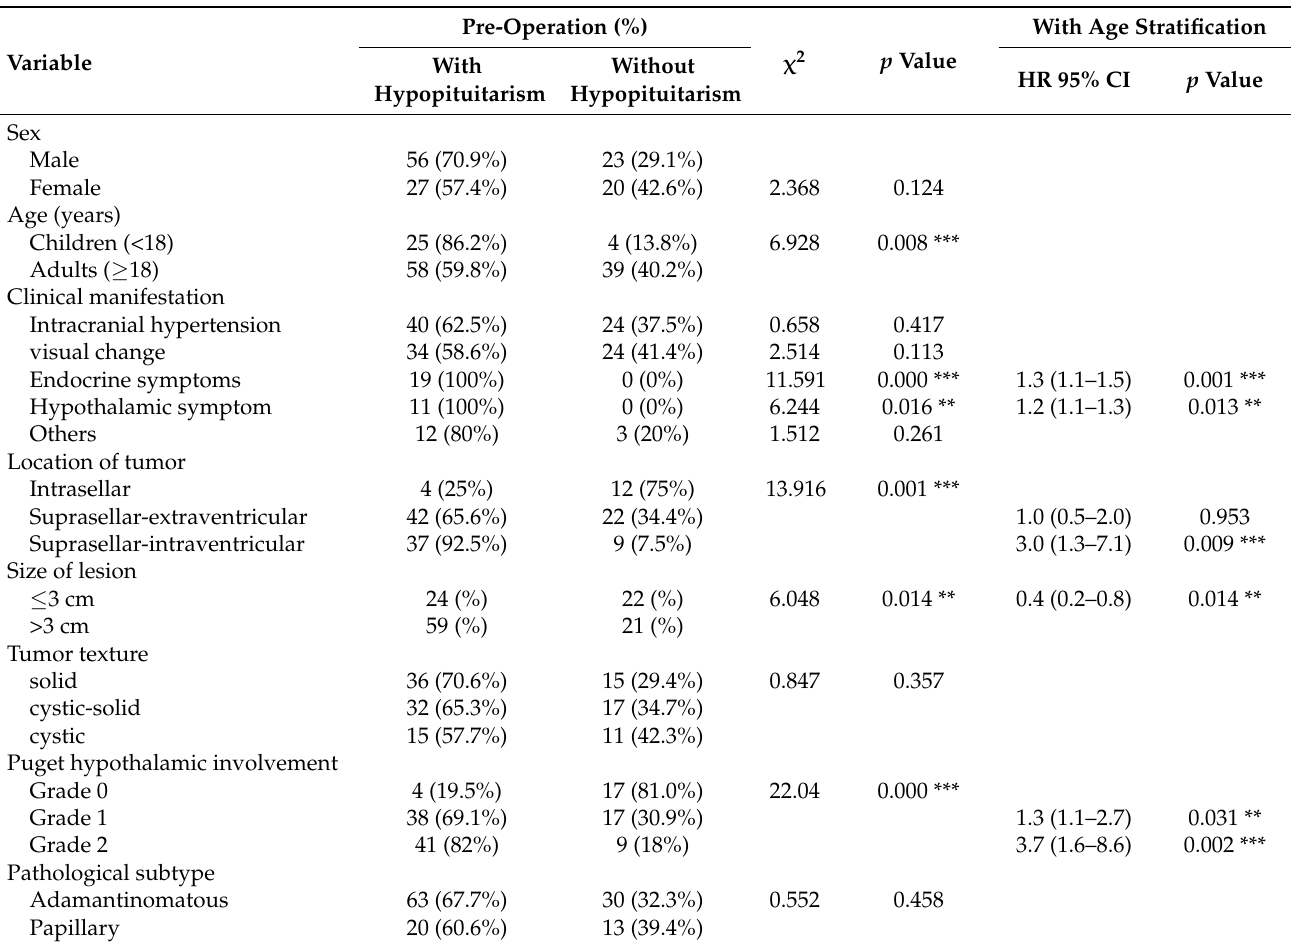
Table 2. Univariate analysis of factors related to preoperative hypopituitarism in craniopharyngioma patients and age stratification (child and adult at diagnosis).